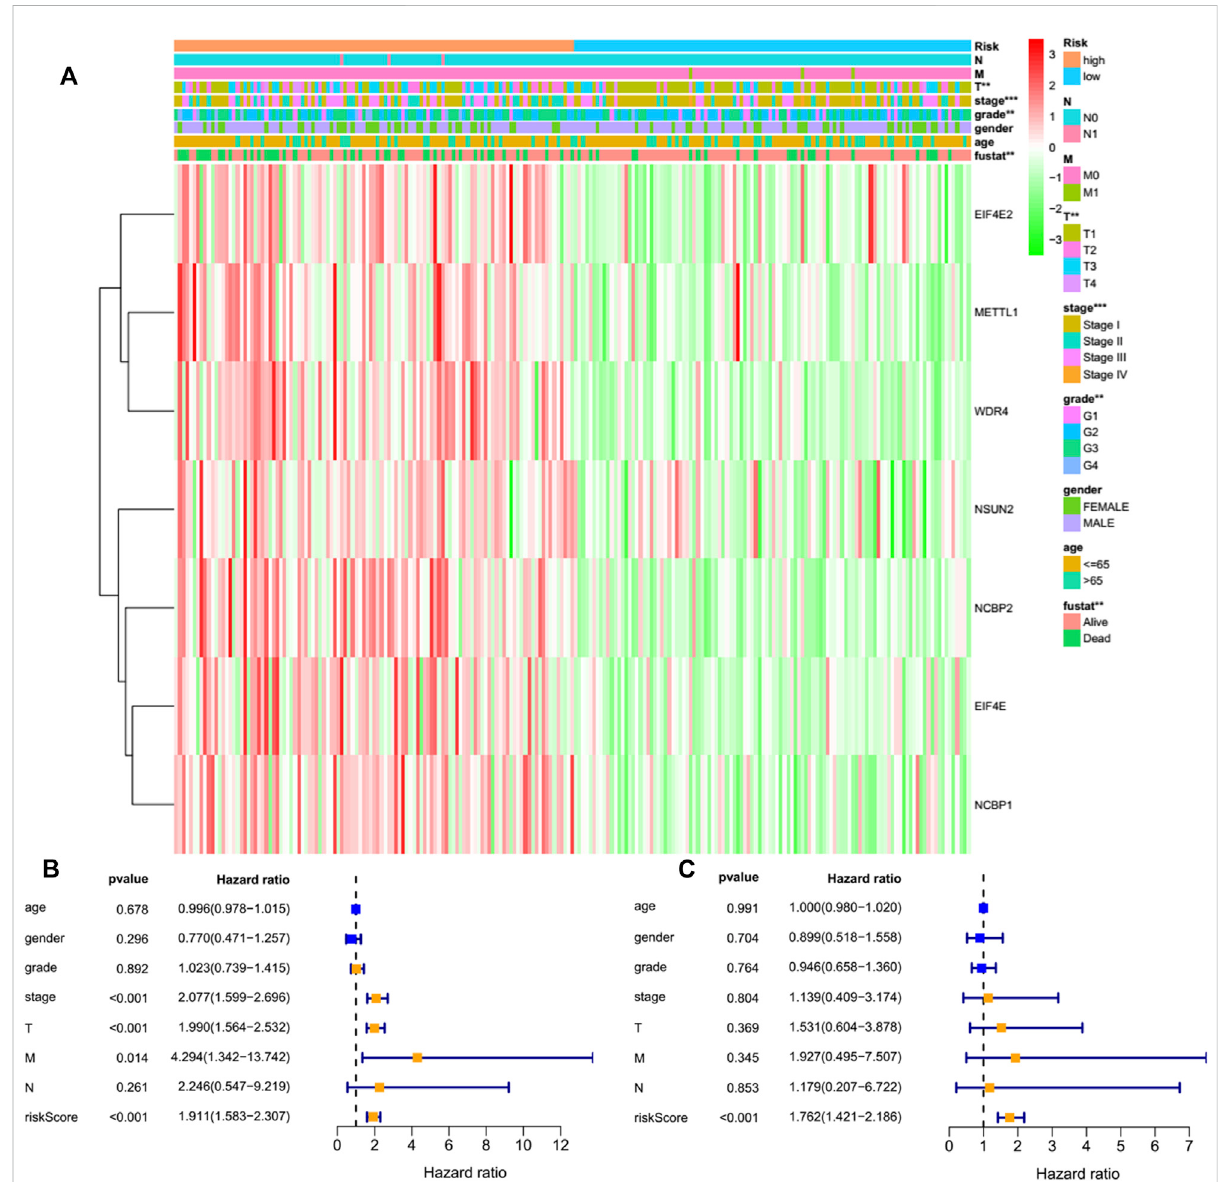
FIGURE 7 EffectsoftheriskscoreandtheclinicopathologicalcharacteristicsontheprognosisofinvalidswithHCC. (A) Heatmapmanifeststhedistribution ofclinicopathologicalcharacteristicsandtheexpressionsofsevenm7GRNAmodi fi cationregulatorsinhigh-andlow-riskgroups. (B) UnivariateCox regressionanalysesoftheclinicopathologicalparametersandOS. (C) MultivariateCoxregressionanalysesoftheclinicopathologicalparametersand OS. ** p < 0.01, *** p <